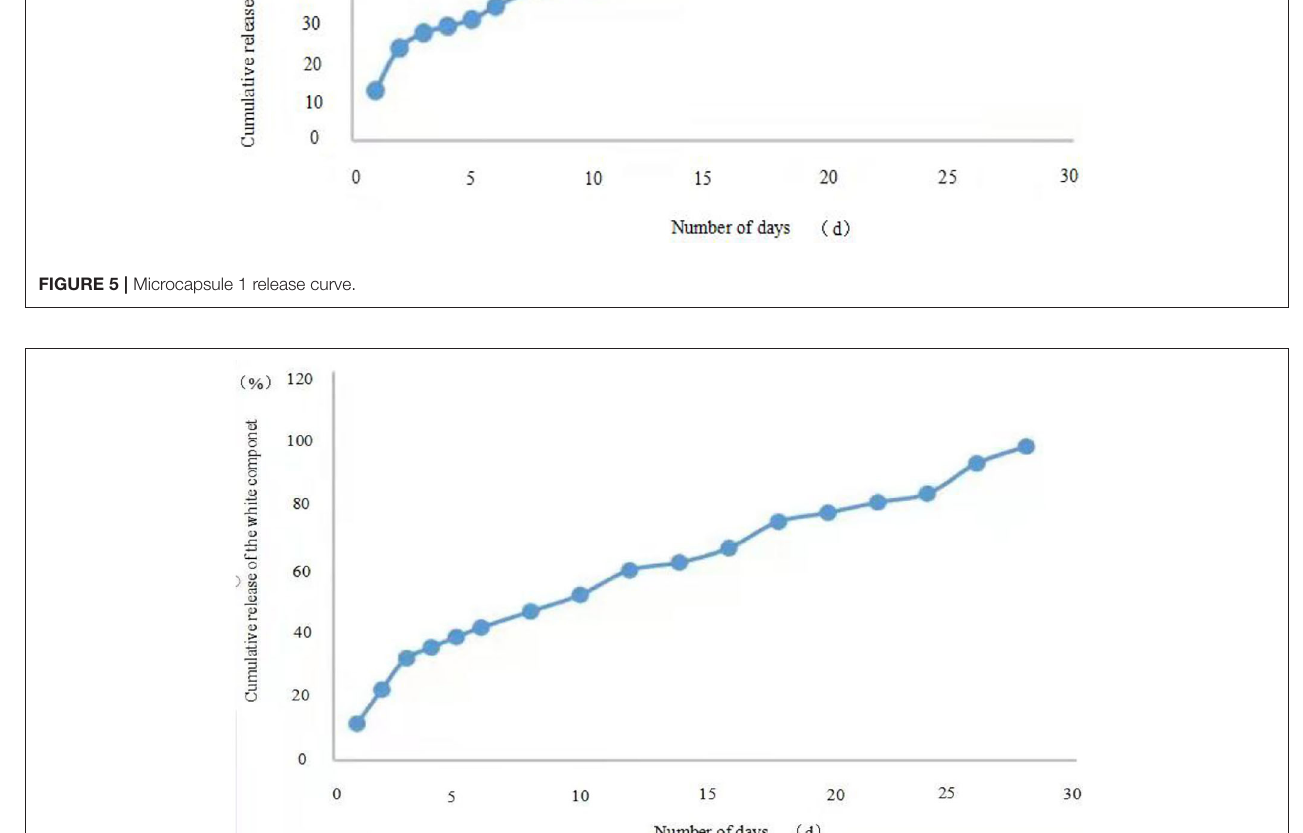
FIGURE 6 | Microcapsule 2 release